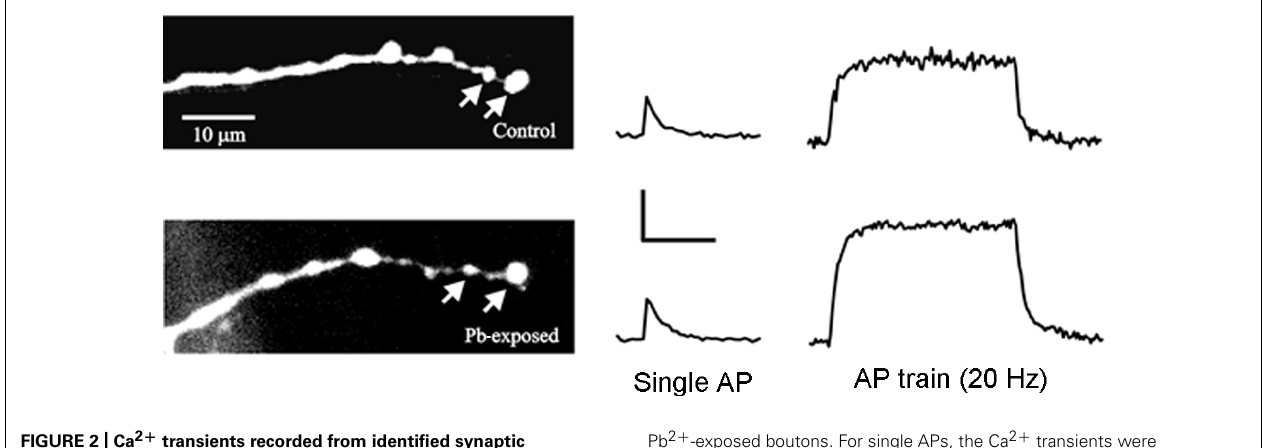
Pb 2 + -exposed boutons. For single APs, the Ca 2 + transients were similar for control and Pb 2 + -exposed synaptic boutons; however, the Ca 2 + transients produced by AP trains were larger and decayed more slowly in Pb 2 + -exposed boutons compared to controls. Calibration: single Ap – 20% (cid:2) F/F, 0.4 s; AP train – 20% (cid:2) F/F, 2 s. Adapted from He etal.